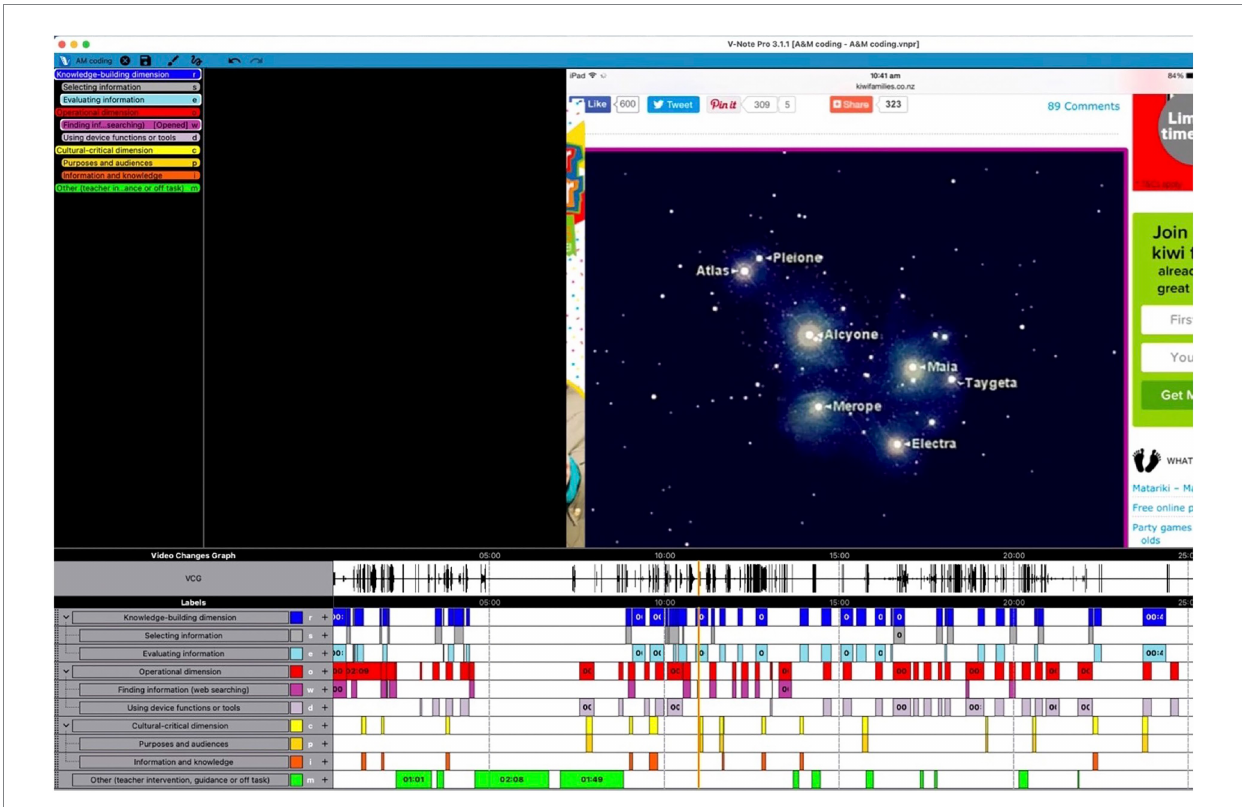
FIGURE 1 Sample V-Note Pro timeline generated from screen recorded data in study